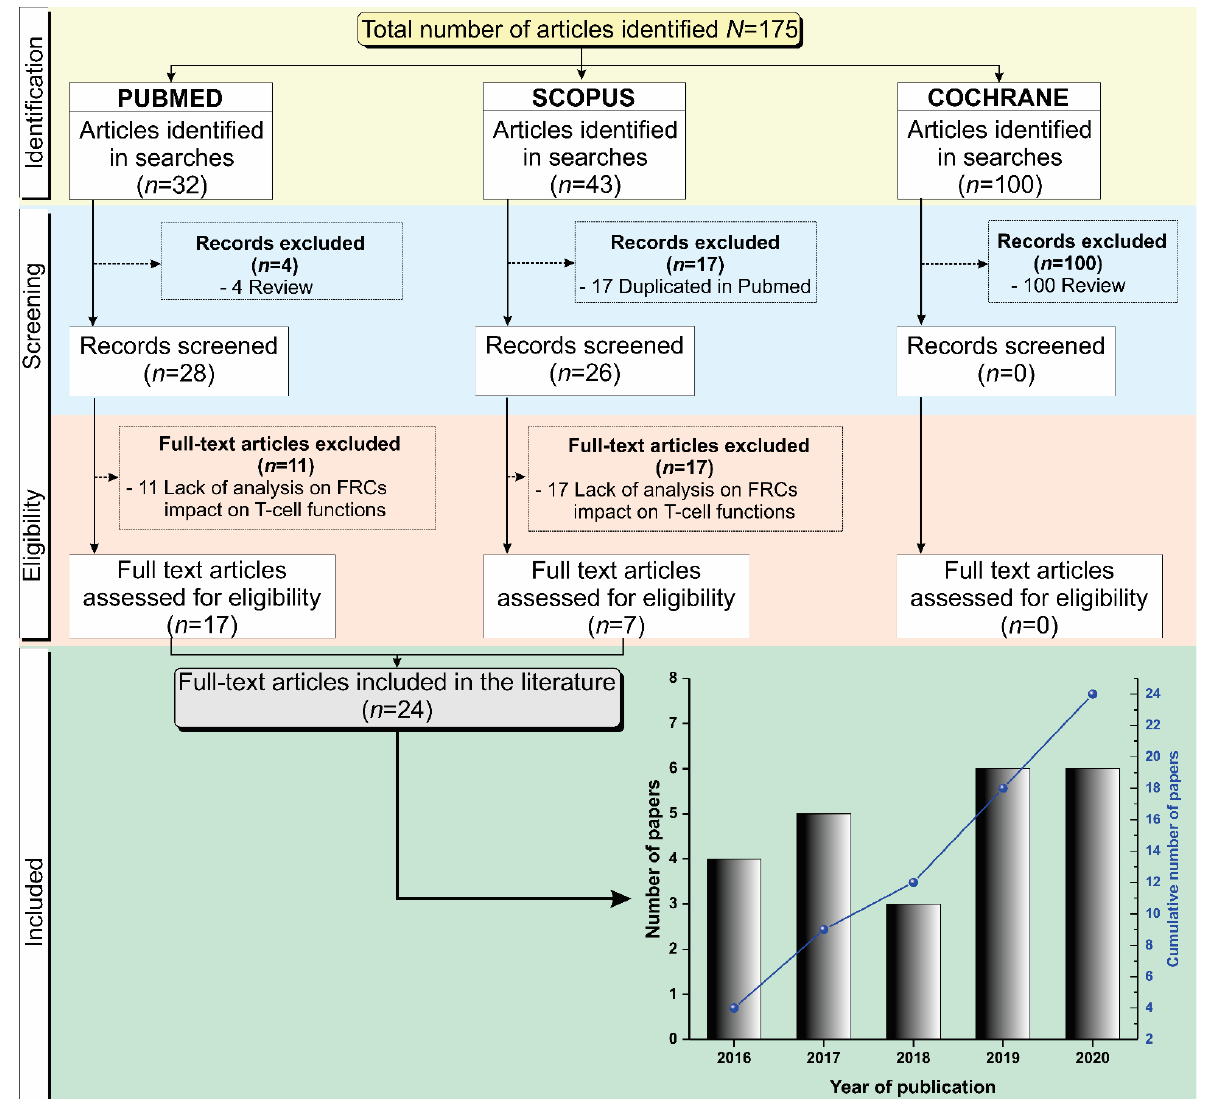
Figure 1. Schematic representation of the article screening process for their inclusion in this systematic review following the PRISMA guidelines. The histogram on the temporal distribution of the 24 articles included in this systematic review, by year of publication.